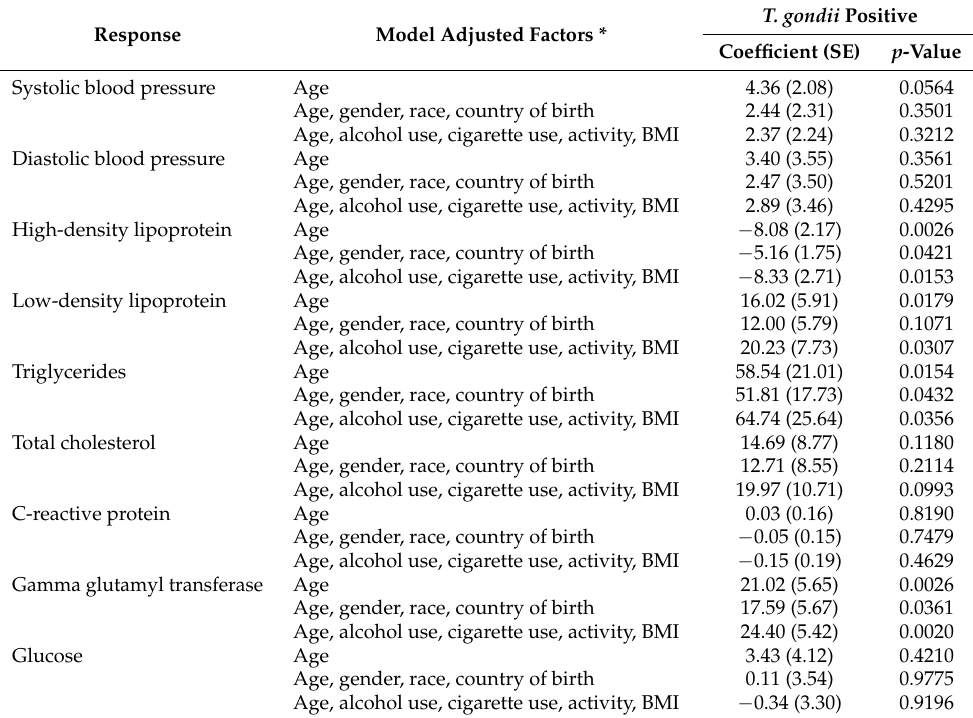
Table 6. Linear regression models to explain the associations between T. gondii (positive/negative) and cardiovascular biomarkers (adjusted for demographic or behavioral and anthropometric